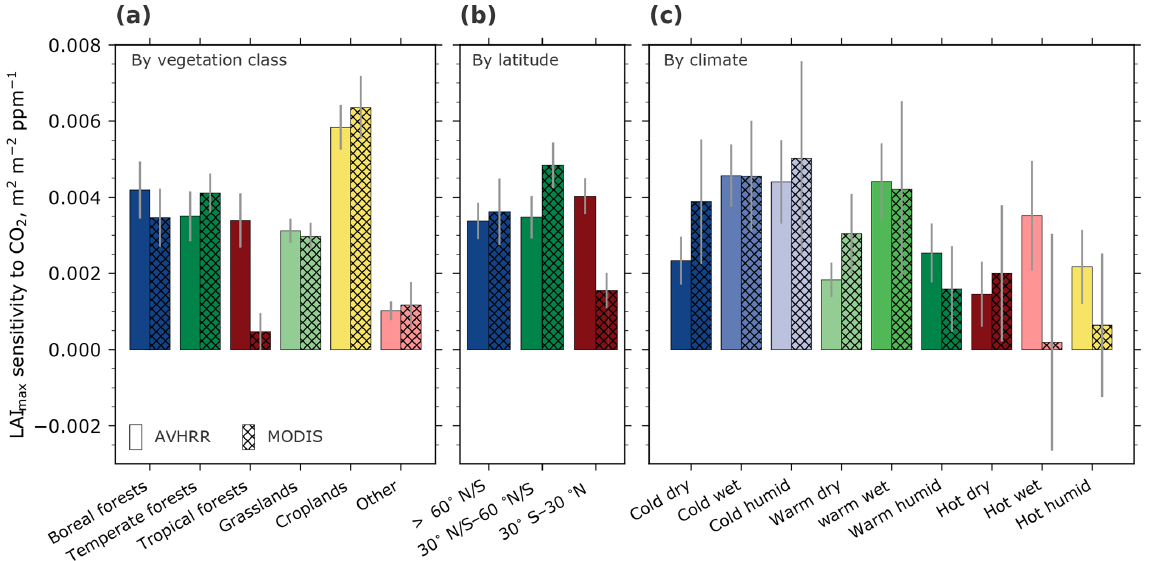
Figure 2. Bar charts showing regression slopes of LAI max against atmospheric CO 2 concentration for broad vegetation classes (a) (Olson et al., 2001; Fritz et al., 2015), latitudinal bands (b) , and climate regimes (c) . The class “Other” includes deserts, mangroves, barren and urban land, snow and ice, and permanent wetlands. The climatic boundaries are defined as follows: cold: < 10 ◦ C; warm: > 10 and < 25 ◦ C; hot: > 25 ◦ C; dry: < 500mma − 1 ; wet: > 500 and < 1000mma − 1 ; humid: > 1000mma − 1 . Sensitivities evaluated from data from two satellite-borne sensors are shown, AVHRR (1982–2016; Pinzon and Tucker, 2014) and MODIS (2000–2016; Yan et al., 2016a, b). Gray bars indicate the standard error of the best linear